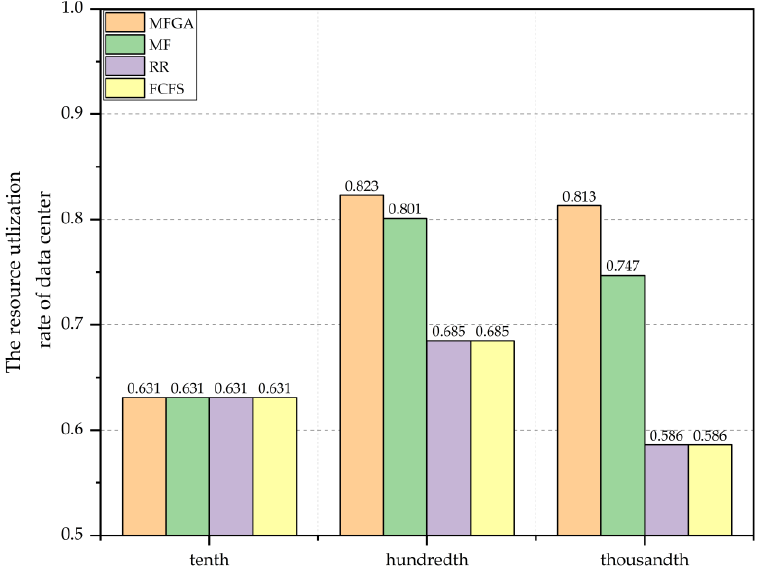
Figure 9. Comparison of the resource utilization rate of data center compared with four algorithms.